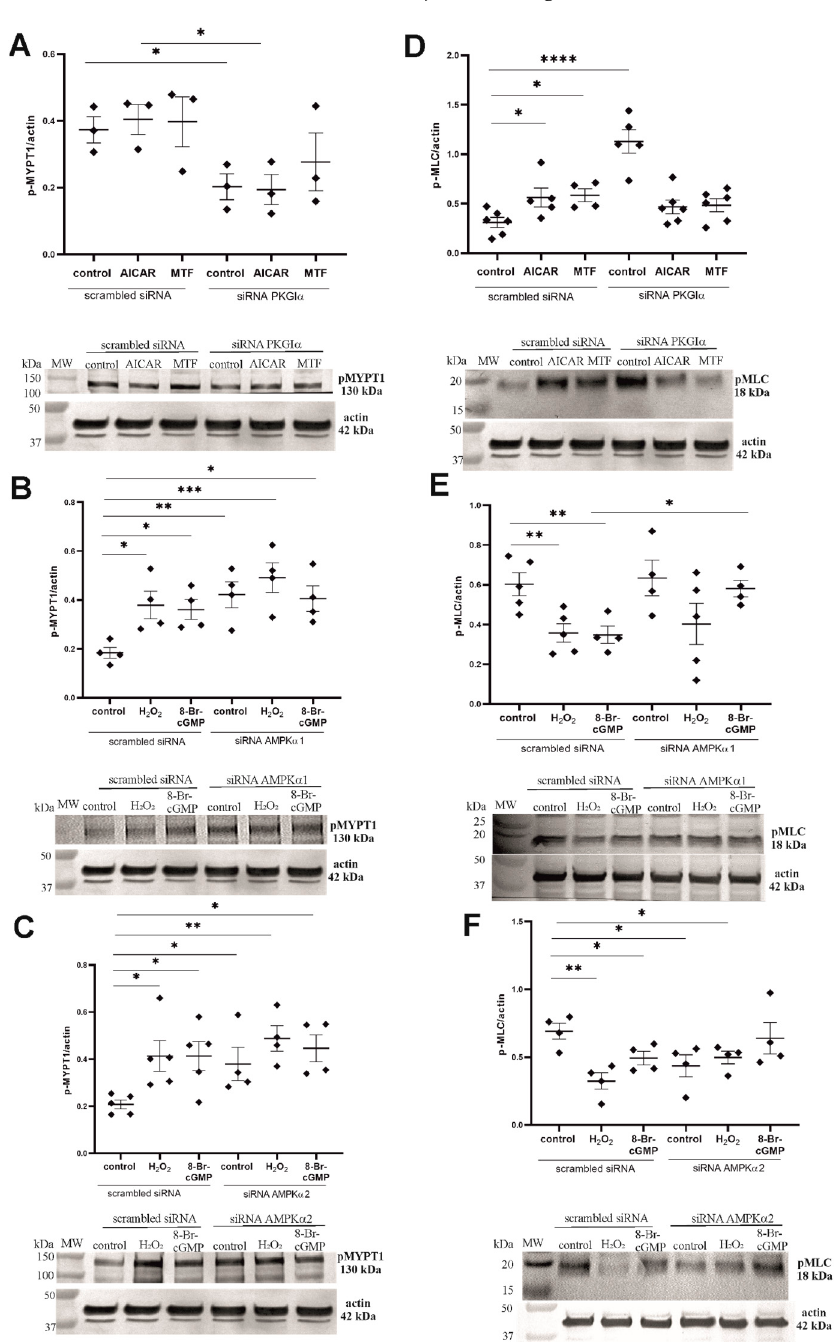
Figure 7. PKGI α and AMPK mutually regulate the contractile apparatus in cultured rat podocytes. ( A , B ) Effect of PKGI α gene-silencing on MYPT1 ( A ) and MLC ( B ) phosphorylation in the presence of the AMPK activators MTF (2 mM, 2 h) and AICAR (100 μ M, 2 h); ( C – F ) Effect of AMPK α 1 ( C , D ) and AMPK α 2 ( E , F ) gene-silencing on MYPT1 and MLC phosphorylation in the presence of the PKGI activators 8-Br-cGMP (100 μ M, 5 min) and H 2 O 2 (100 μ M, 5 min). The data were analyzed using Sidak’s test, Dunnett’s test, or unpaired t -test and are expressed as the mean ± SEM. n = 3–6. * p < 0.05, ** p < 0.01, *** p < 0.001, **** p < 0.0001, compared with appropriate siRNA control.